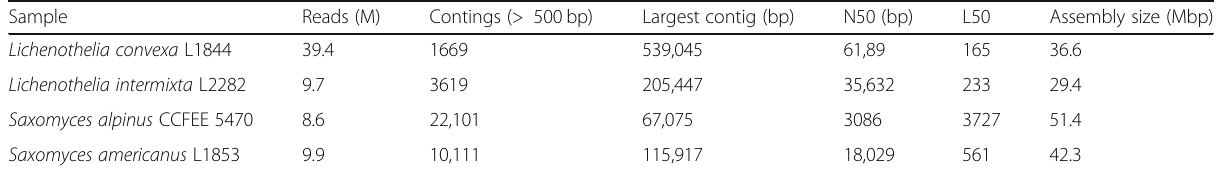
Saxomyces americanus